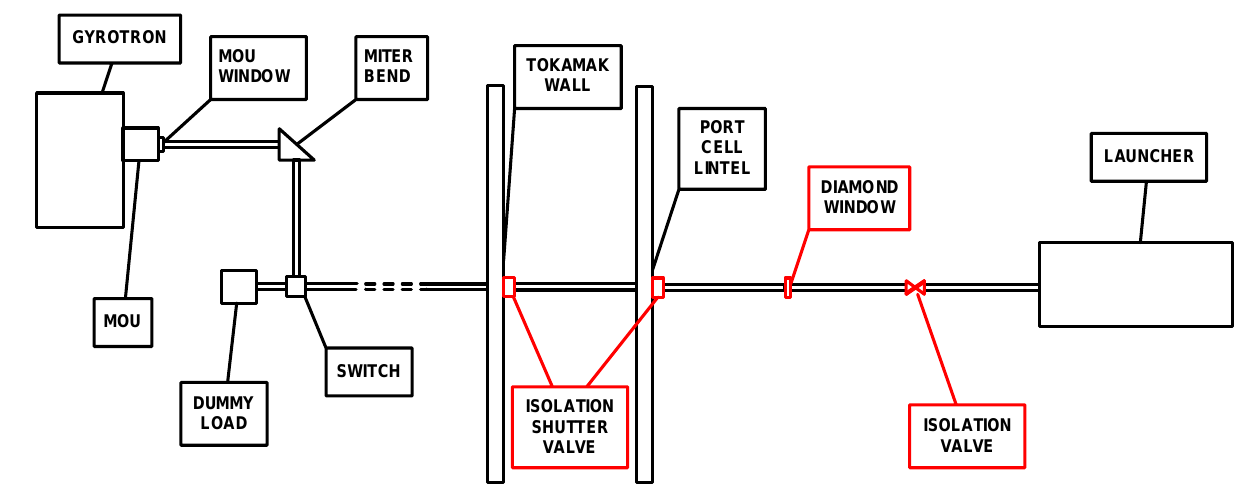
Fig. 4. Simplified layout of a single Transmission